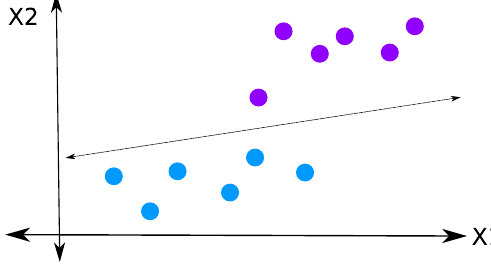
Figure 4. The 2-D distribution of dependent